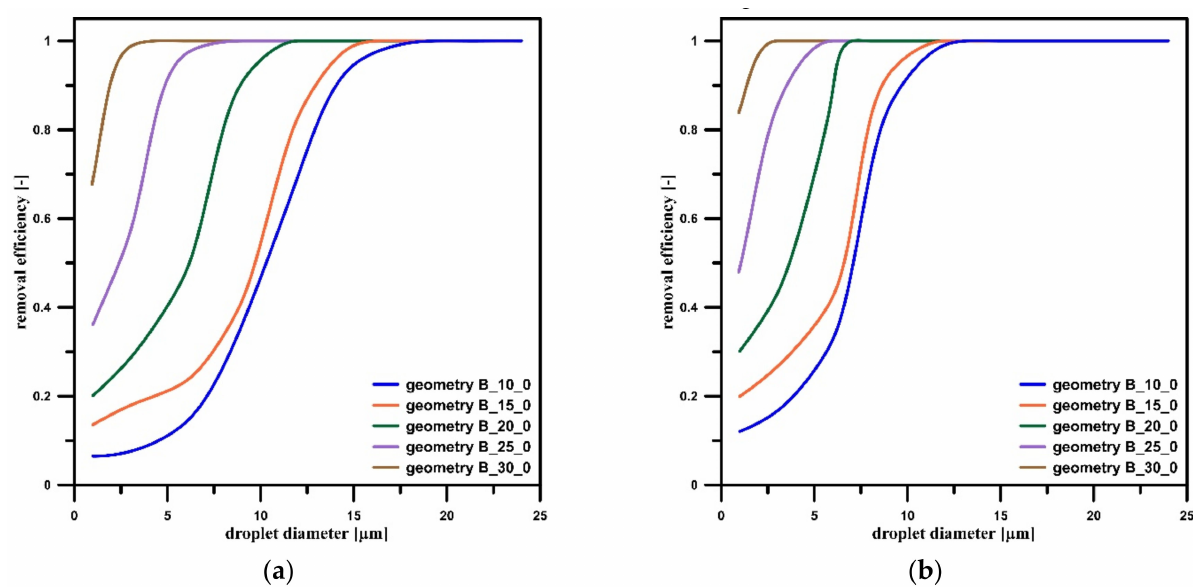
Figure 9. Comparison of calculated results of droplet removal efficiency for geometries with different drainage channel